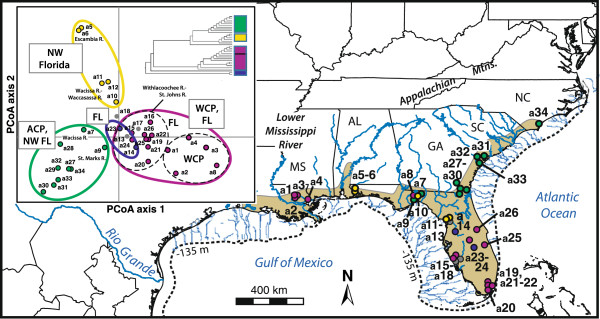
Nuclear allozyme phylogeography. Map of clades inferred from neighbor-joining analysis of unbiased Nei’s D from 11 allozyme loci in [42]. Inset graphic: corresponding tree topology with assigned clade colors, as well as the results of principal coordinates analysis (PCoA) of allele frequency data for the populations, which confirm the neighbor-joining relationships.